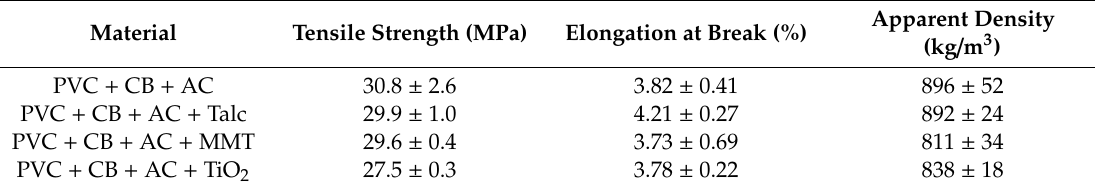
microwave power, reproduced from [56] with permission, copyright Elsevier,